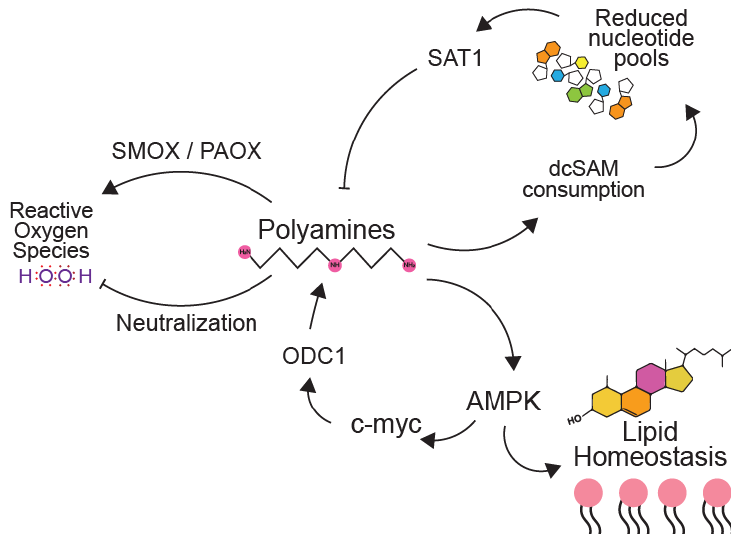
Figure 5. Polyamines affect diverse metabolic pathways in mammalian cells. Polyamine synthesis consumes decarboxylated S-adenosyl methionine (dcSAM), resulting in reduced nucleotide pools. These reduced nucleotide pools induce SAT1, which depletes polyamines, resulting in a feedback loop. The interconversion of polyamines via SMOX and PAOX accumulates reactive oxygen species, specifically hydrogen peroxide (H 2 O 2 ). Polyamines also are described to neutralize reactive oxygen species due to their abundance and charge. Additionally, polyamines maintain AMPK in its unphosphorylated, non-activated state to maintain lipid homeostasis. AMPK activation induces polyamine synthesis through c-myc mediated ODC1